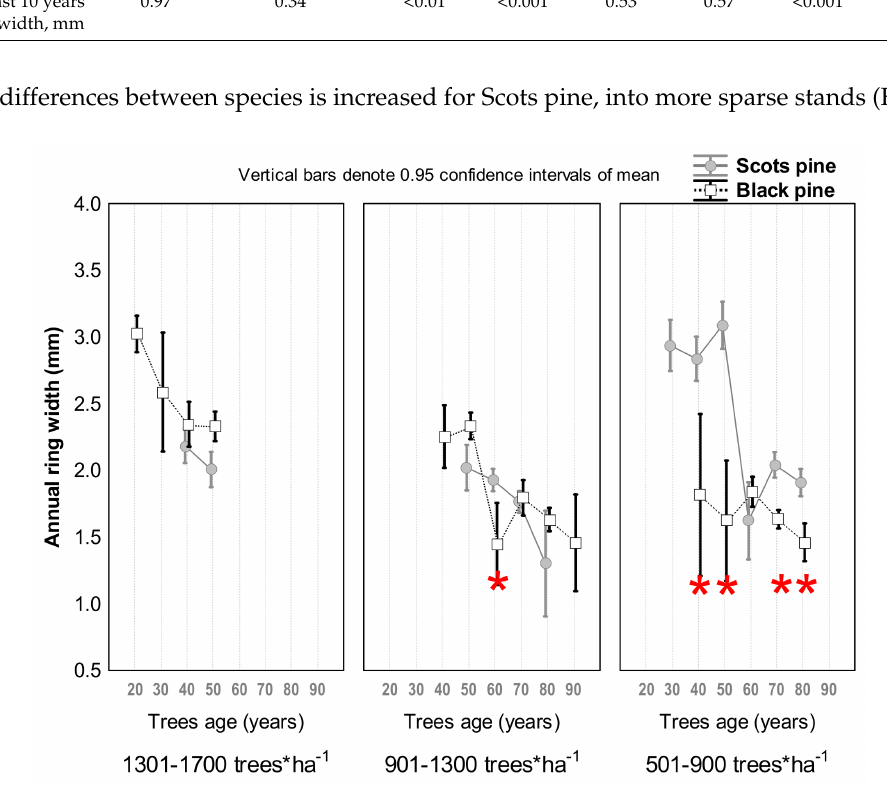
Figure 2. Specie x tree age x stand density interaction in pines radial growth at breast height (the asterisks mark significant differences ( p <